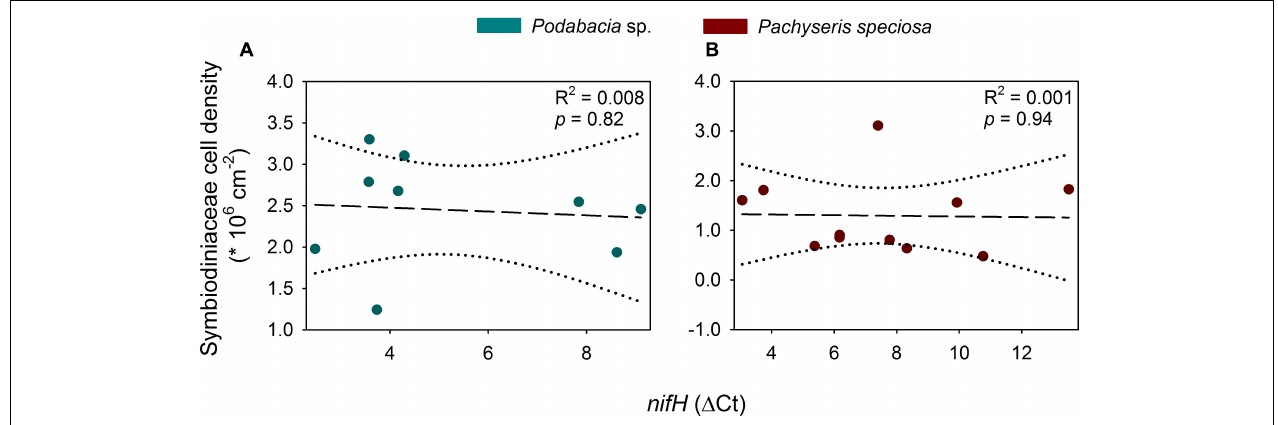
FIGURE 3 | Linear regression analyses for cell density of Symbiodiniaceae and (cid:49) Ct of nifH (relative to the corresponding 16S rRNA Ct value) for Podabacia sp. (A) and Pachyseris speciosa (B) . Dotted lines represent 95% confidence intervals. Symbiodiniaceae cell density data was obtained from Ziegler et al. (2015).